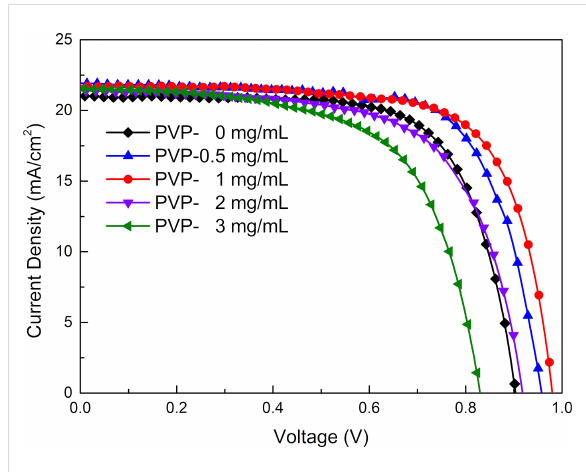
Figure 4: The current density–voltage curves of the perovskite solar cells fabricated under different conditions.